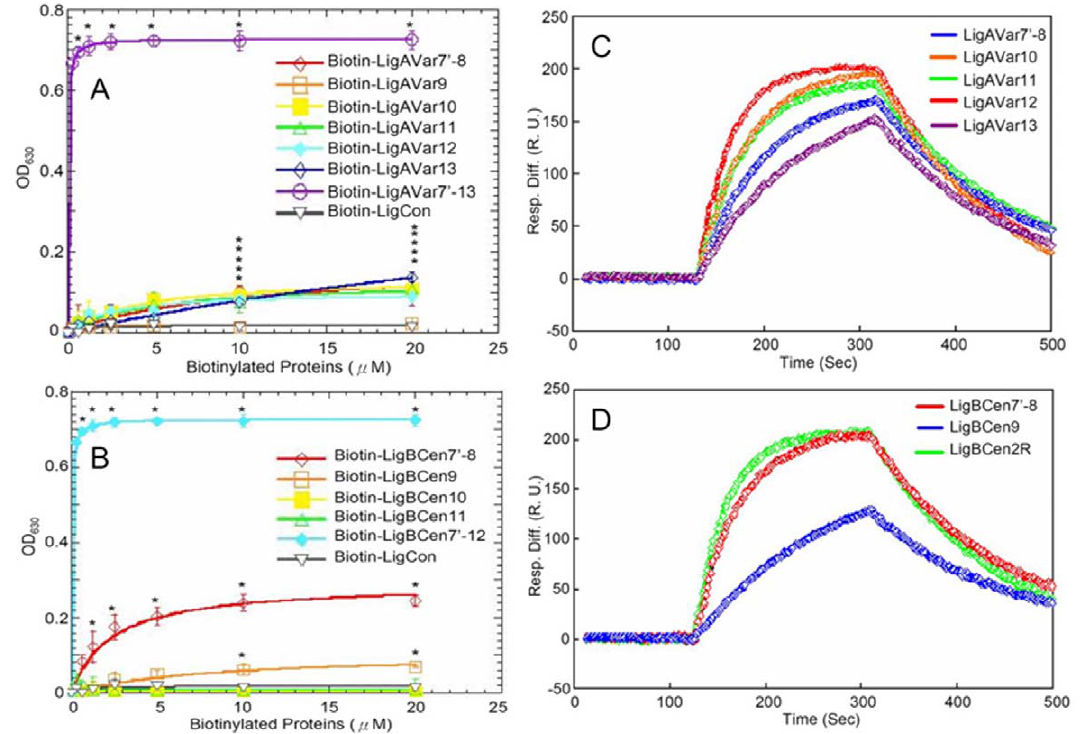
Figure 2. Localization of the GBD-binding domains on Lig proteins. (A and B) Various concentrations (0, 0.3125, 0.625, 1.25, 2.5, 5, 10, 20 m M) of biotinylated LigCon (negative control), and (A) LigAVar7’-13 (positive control), LigAVar7’-8, LigAVar9, LigAVar10, LigAVar11, LigAVar12, LigAVar13, (B) LigBCen7’-12 (positive control), LigBCen7’-8, LigBCen9, LigBCen10, LigBCen11 were added to wells coated with 1 m M of GBD or BSA (negative control and data not shown) in Tris buffer. The binding of biotinylated proteins to GBD was measured by ELISA. For all experiments, each value represents the mean 6 SEM of three trials in triplicate samples. Statistically significant (p , 0.05) differences compared to the negative control are indicated by an asterisk. (C and D) SPR analysis of Ig-like domains of Lig interacting with GBD 1.5 m M of Recombinant Histdine-tag (C) LigAVar7’-8, LigAVar10, LigAVar11, LigAVar12, LigAVar13, (D) LigBCen7’-8, LigBCen9, or LigBCen2R was immobilized on the surface of Ni-NTA chip. GBD in Tris Buffer containing 100 m M CaCl2 at pH 7.5 was flowed through the chip and the concentration of GBD ranged from 40 to 0.625 m M. Only the response sensograms of the 40 m M of GBD are shown. The KD, kon, koff were obtained from the average of duplicate experiments shown in Table 1.